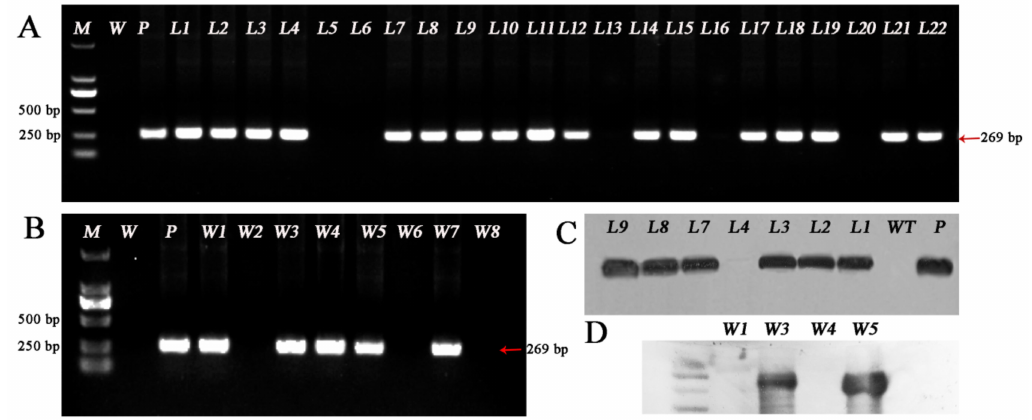
Figure 4. Polymerase chain reaction (PCR) analysis of transgenic plantlets using the GUS gene. A Only 22 Lilium pumilum DC. Fisch. lines are shown B Only 8 White Heaven’ lines are shown, and others no band was amplified. Lane M, DL2000 DNA marker; lane W, wild-type plant; lane P, plasmid control; lanes L1–22 are GUS-positive lines of Lilium pumilum DC. Fisch. and lanes W1–8, are GUS-positive lines of ‘White Heaven’. C , D Southern blot analysis of transformation. lane WT, wild-type plant; lane P, plasmid control; lanes L1-9, Only 9 PCR-positive transgenic lines of Lilium pumilum DC. Fisch. are shown. lanes W1, W3, W4 and W5, PCR-positive transgenic lines of ‘White Heaven’. W7 no band was